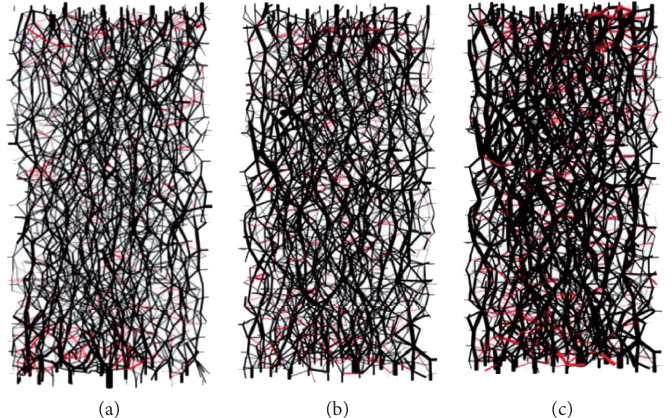
Figure 8: Contact force chains of discrete element samples with different moisture contents under σ (b) w � 7 . 8%. (c) w � 9 . 1%.